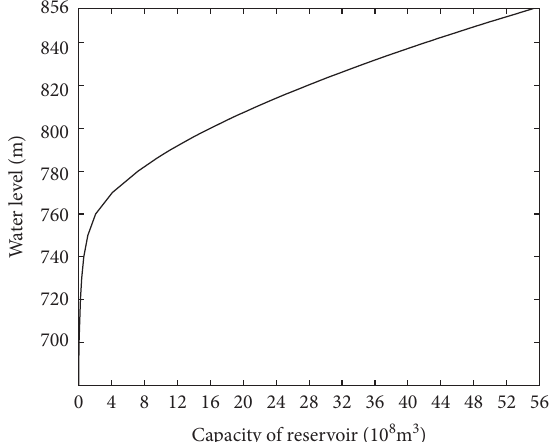
Figure 8: The water level-storage capacity curve for the PBG